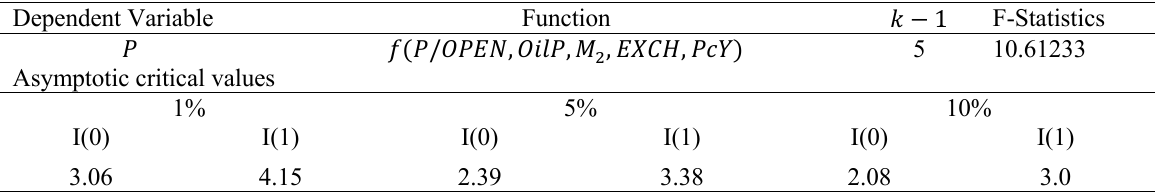
Table 2: Result from Bound Test Dependent